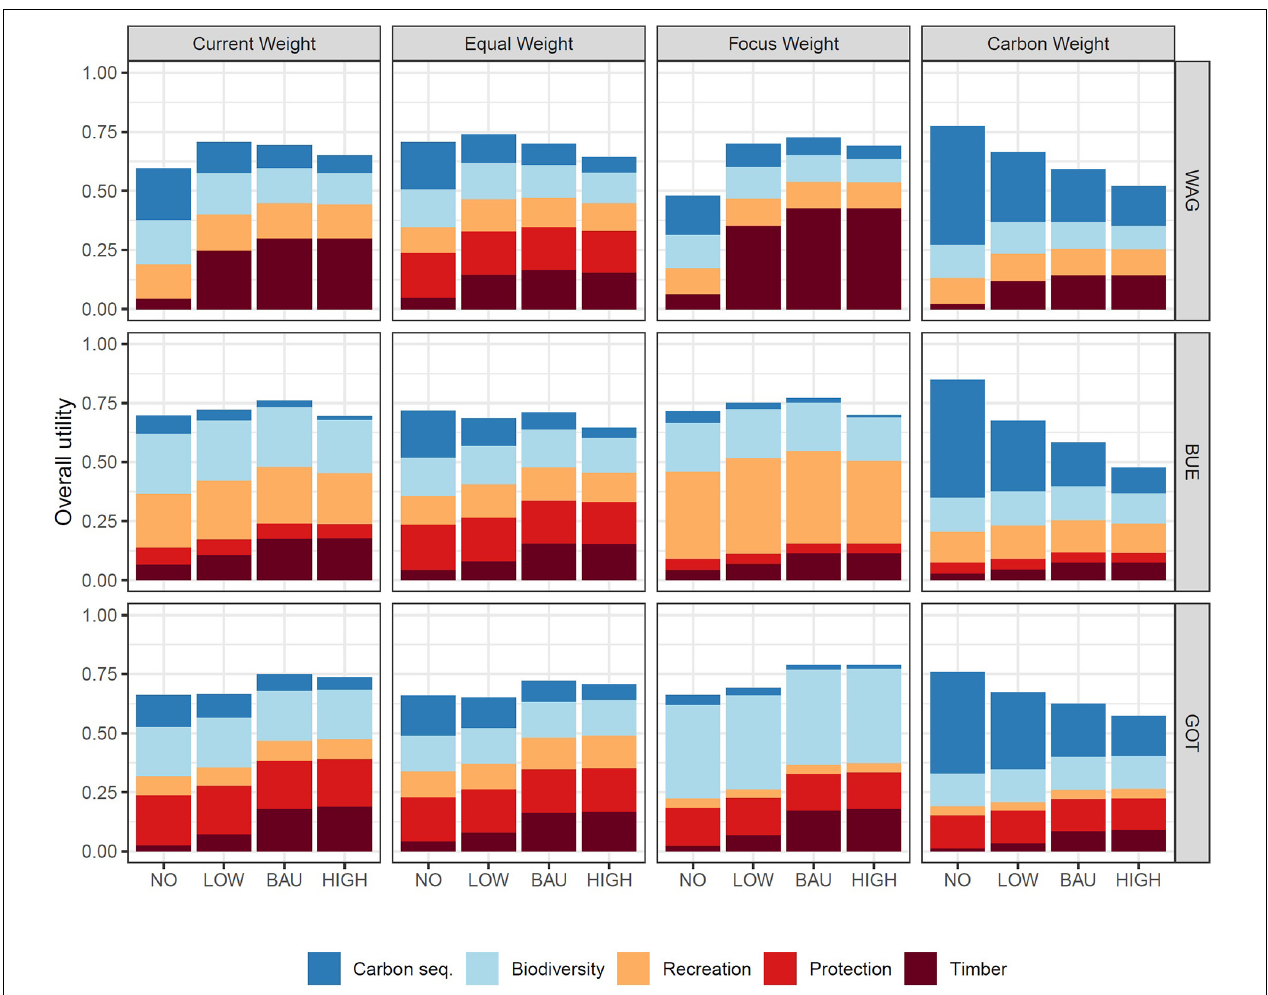
FIGURE 6 | Overall utility for four alternative biodiversity and ecosystem service (BES) weighting preferences ( Table 4 ), for four management strategies at three case study enterprises (WAG, BUE, GOT) under present climate (year 2060). For underlying weighting scheme, see Table 4